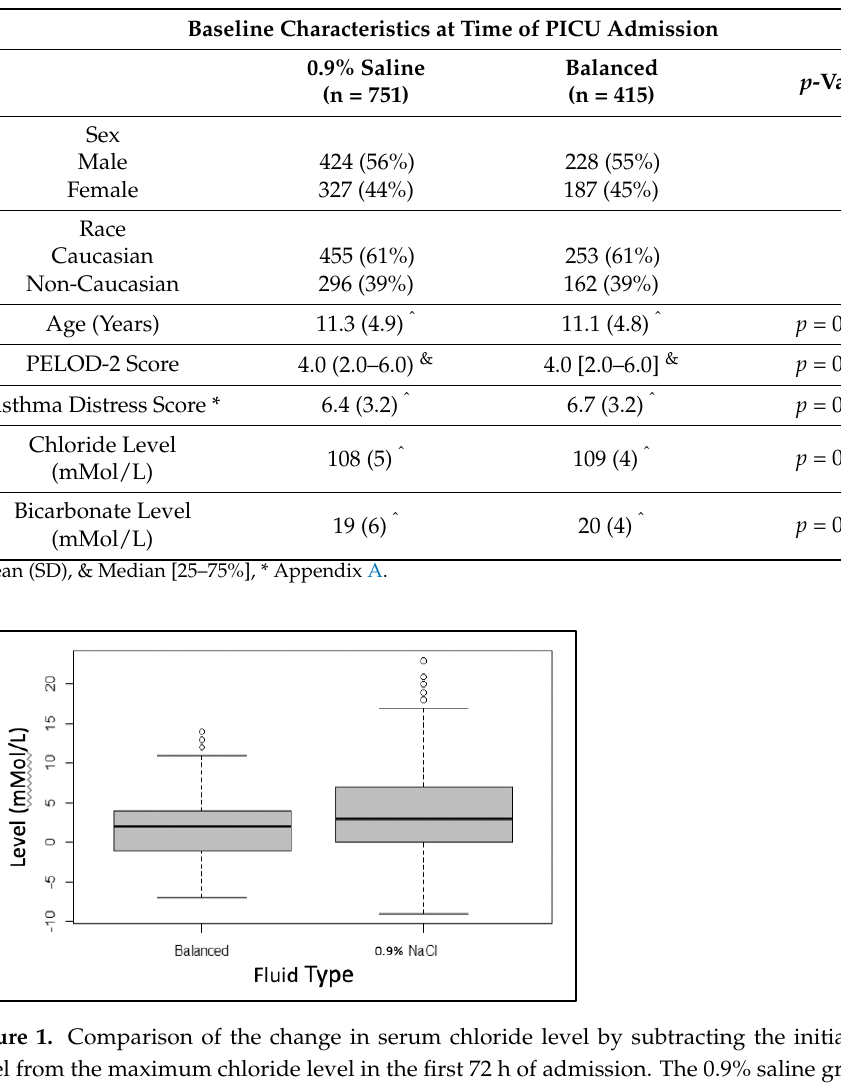
Table 1. Baseline characteristics at time of PICU admission. Categorical variables are summarized as number (%) and compared with Chi-square analysis. Normally distributed variables are reported as mean (SD) and compared with independent samples t -test, while non-normally distributed con- tinuous variables are reported as median (IQR) and compared with Wilcoxon rank sum. Refer to